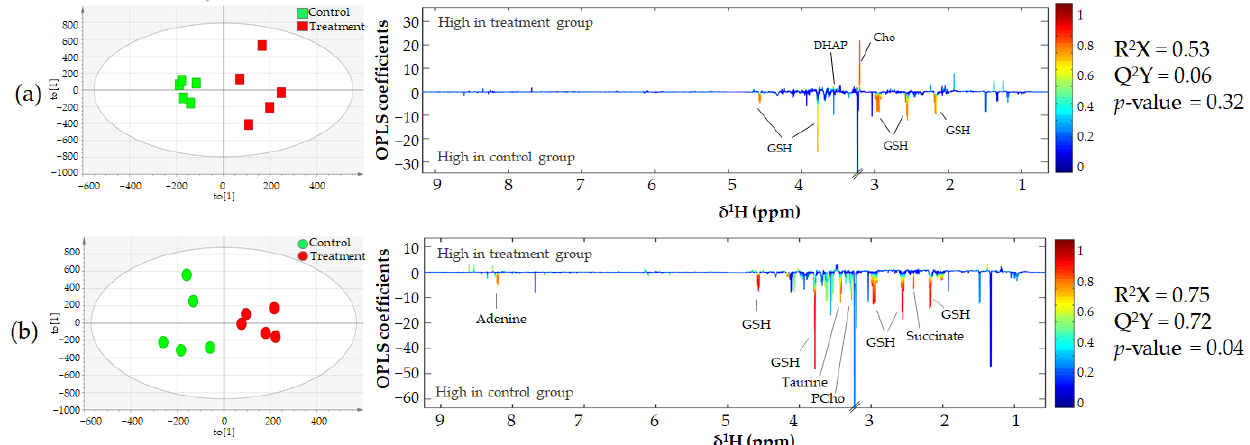
Figure 6. OPLS-DA scores (left panel) and loadings (right panel) plots displaying significantly changed intracellular metabolite levels after treatment with or without 200 µ g/mL CA on ( a ) KKU-100 and ( b ) KKU-213 cell lines. The positive peaks of the OPLS-DA loading plot indicate metabolites higher in the treatment group, whereas the negative peaks represent metabolites higher in the control group. The color of the peaks corresponds to the correlation coefficients in the discrimination model.